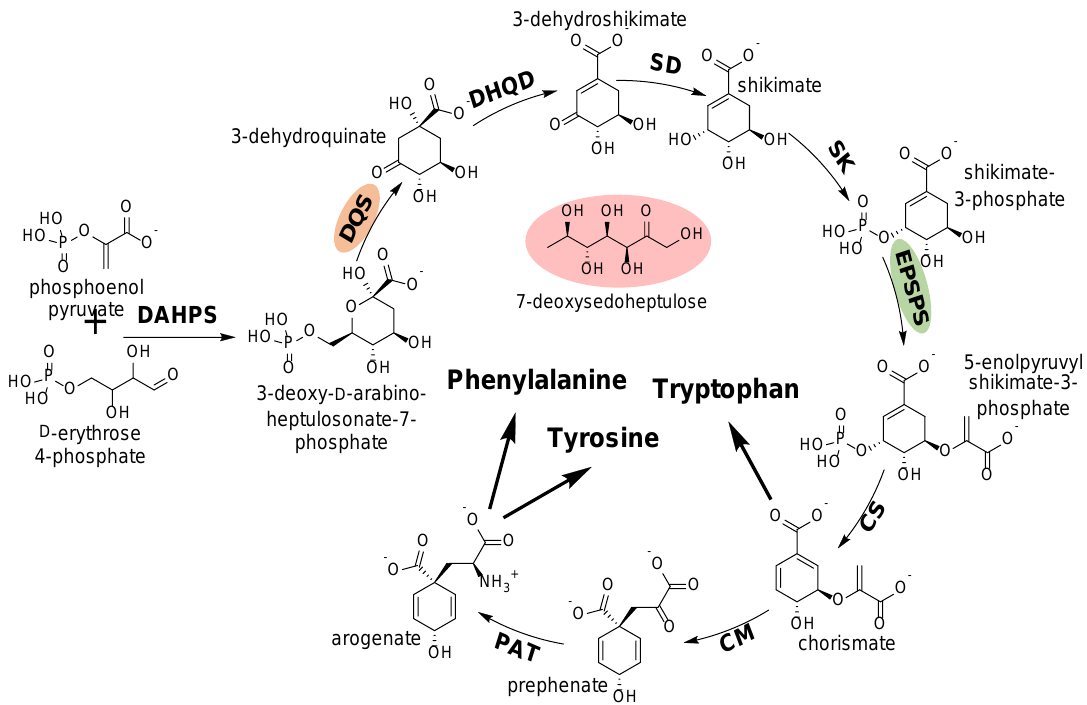
Figure 6. Shikimate pathway and aromatic amino acid biosynthesis showing the metabolites formed at each step catalyzed by the enzymes abbreviated in bold. The target site of glyphosate is EPSPS (green). The target site of the antimetabolite 7-deoxysedoheptulose (red) is DQS (orange). DAHPS: 3-deoxy- d -arabino-heptulosonate-7-phosphate synthase, DQS: 3-dehydroquinate synthase, DHQD / SD: 3-dehydroquinatede hydratase, SK: shikimate kinase, EPSPS: 5-enolpyruvylshikimate 3-phosphate synthase, CS: chorismate synthase, CM: chorismate mutase, PAT: prephenate aminotransferase.